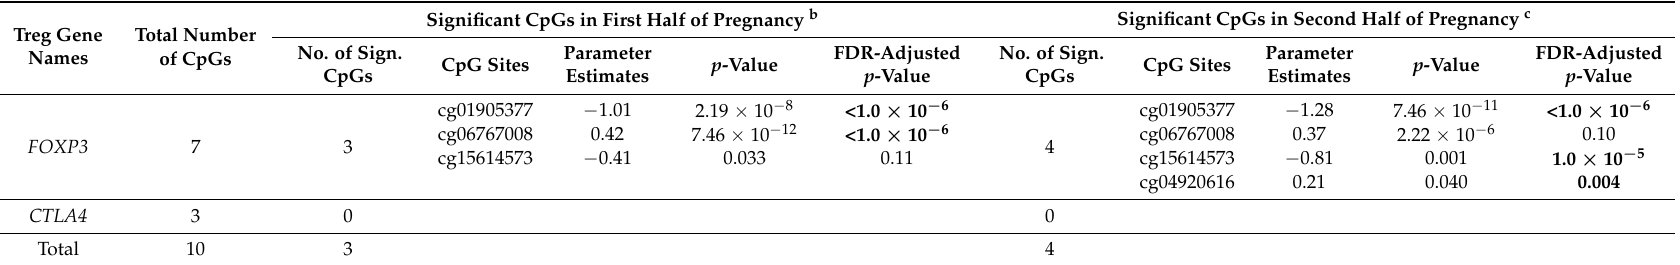
Table 5. Treg CpGs showing statistically significant changes ( p ≤ 0.05) during first and second halves of pregnancy a